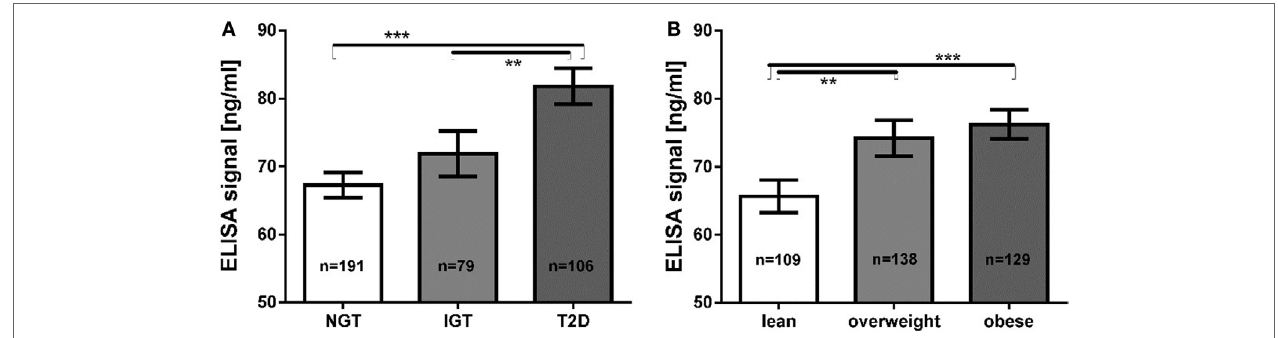
FigUre 5 | (a) Mean zonulin ELISA values according to glucose tolerance groups (B) mean ELISA values according to BMI groups. ** p < 0.01; *** p < 0.001. NGT, normal glucose tolerance; IGT, impaired glucose tolerance; T2D: type 2